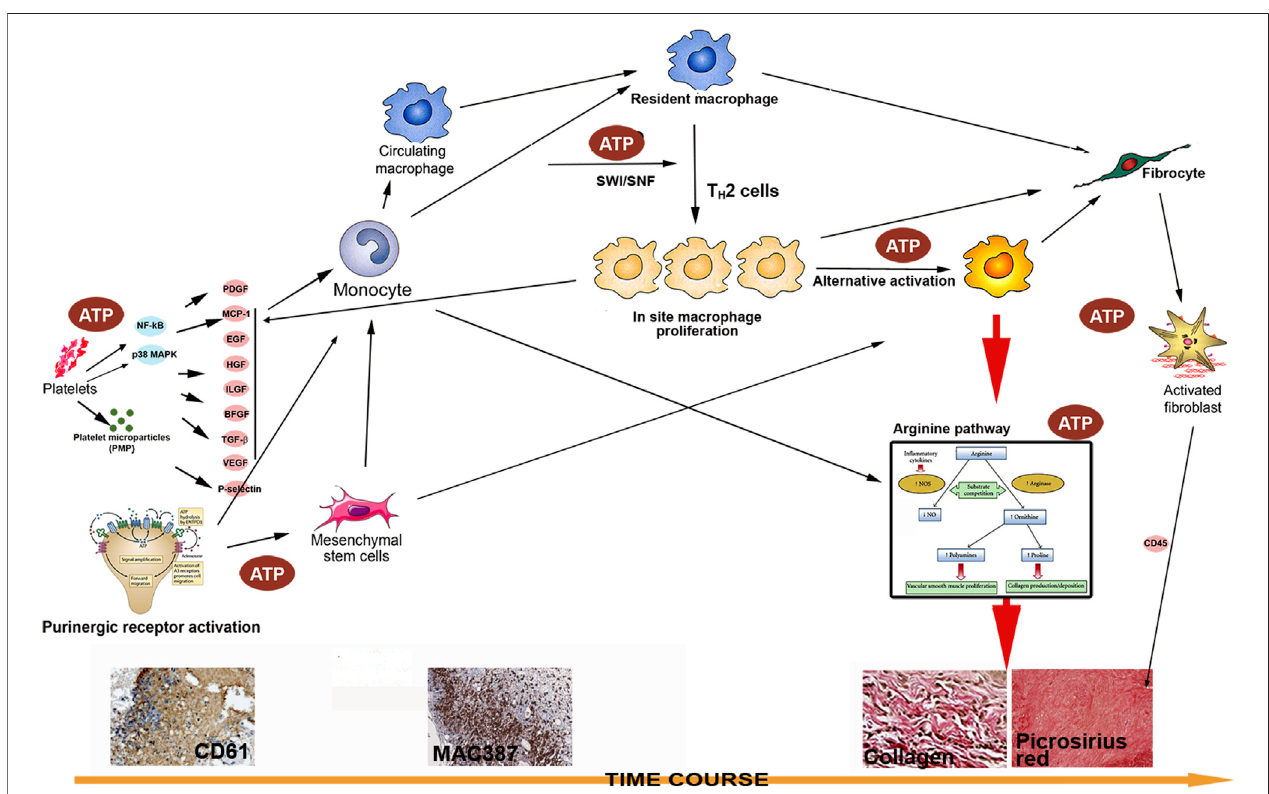
FIGURE 10 | A schematic illustration of possible mechanisms through which intracellular ATP delivery augments incisional wound healing: 1) ATP promotes stem/ progenitor cell traf fi cking, leukocyte chemotaxis, and platelet activation via both purinergic receptor activation and energy enhancement, resulting in early platelet traf fi cking and massive macrophage accumulation; 2) Activated macrophages produce many factors to further encourage traf fi cking, in situ proliferation, and M2 polarization; 3) Activated macrophages produce collagen directly via alternative activation, leading to enhanced and rapid healing.